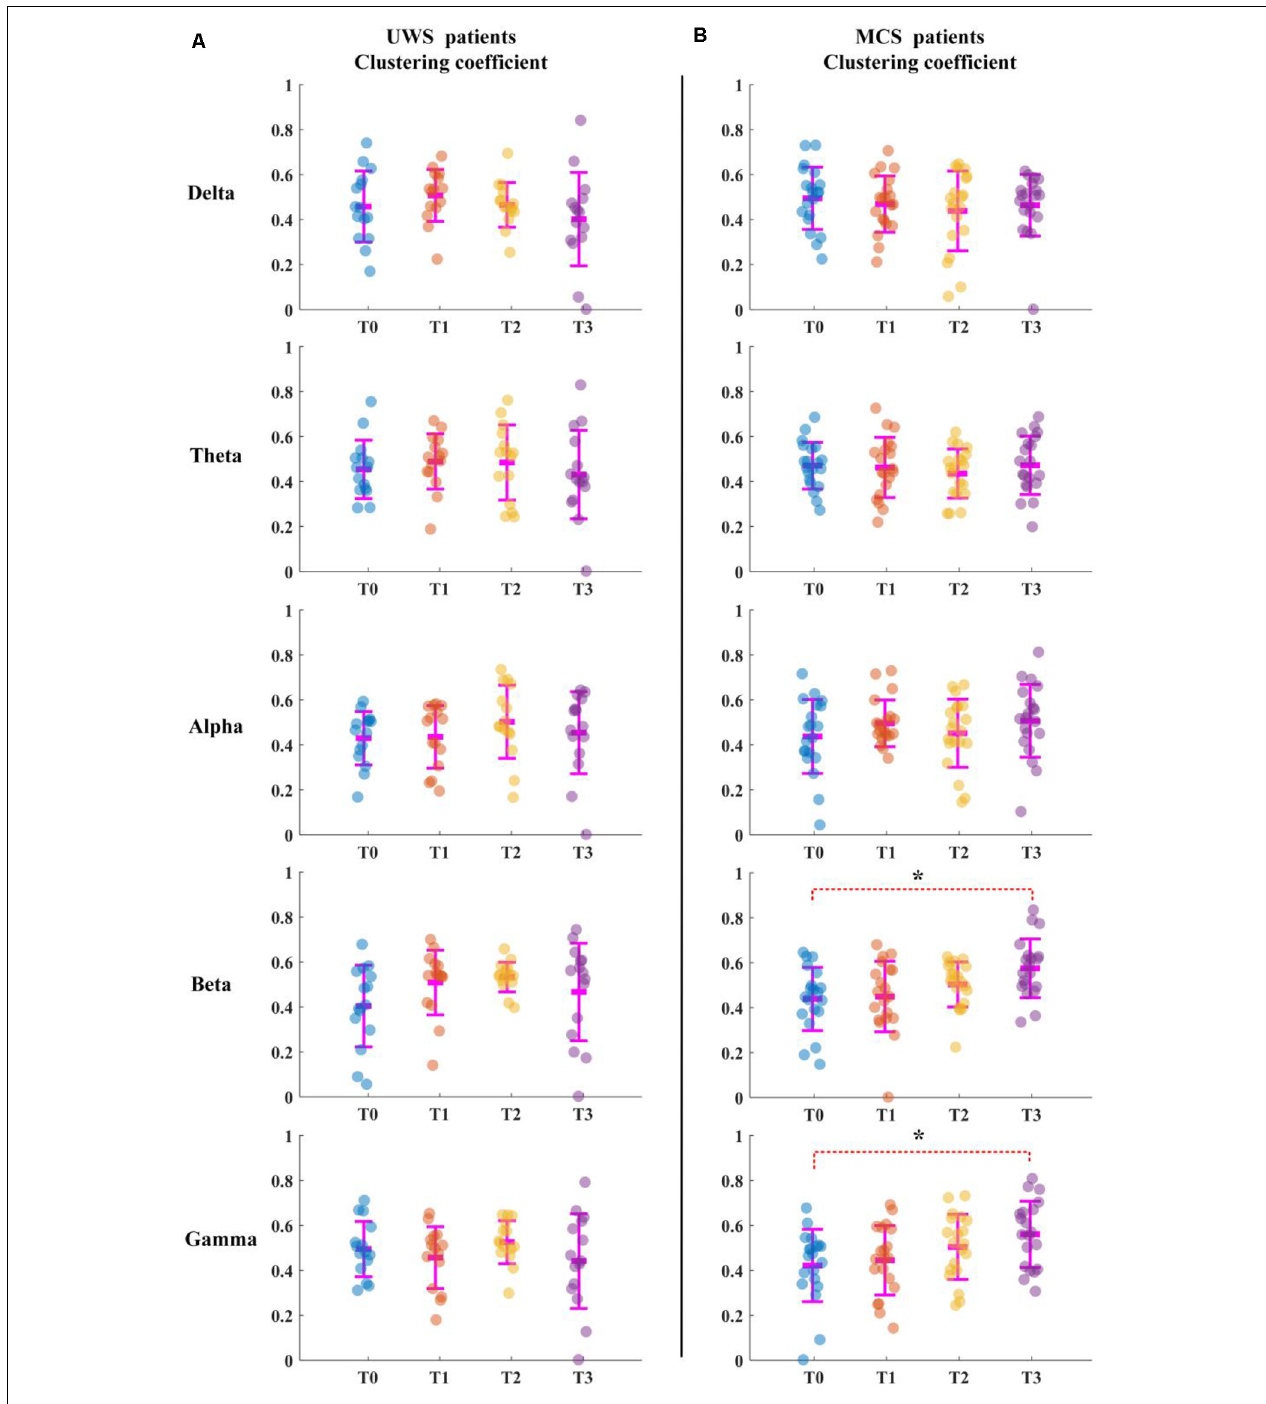
FIGURE 2 | Average clustering coefficient for all patients in five bands. T0, T1, T2, and T3 represent four electroencephalograms (EEG) time points. The scatterplot shows the indicators of each patient. (A) Unresponsive wakefulness syndrome (UWS) patients. (B) Minimally conscious states (MCS) patients. *Denotes p < 0.05, FDR